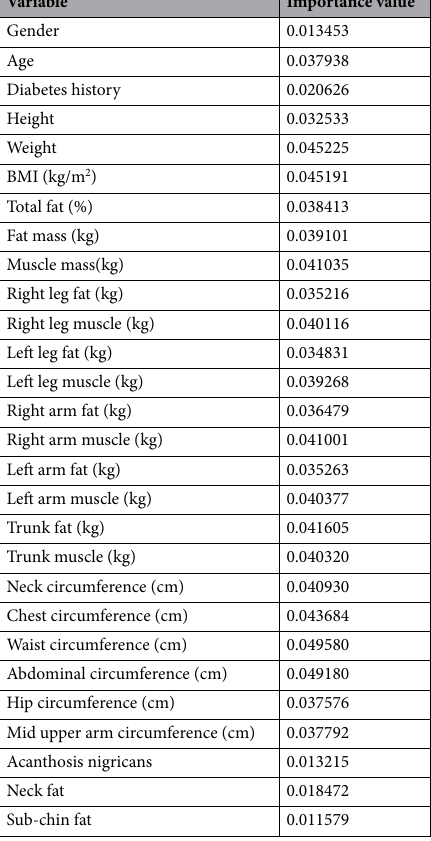
Table 6. Variable importance from the random forest method for